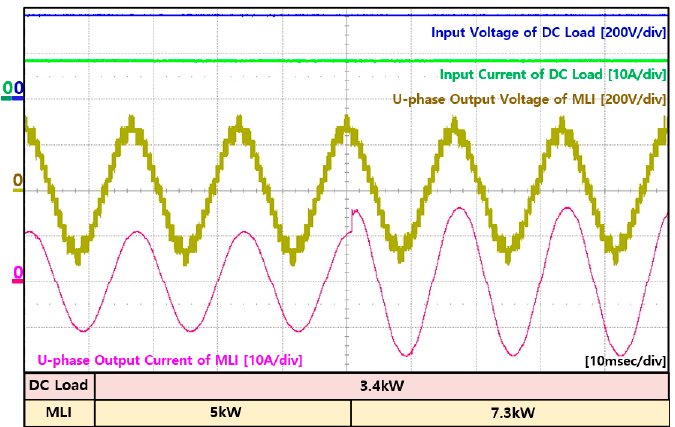
Figure 28. Experiment waveforms of DC load and multi-level inverter in mode 5.